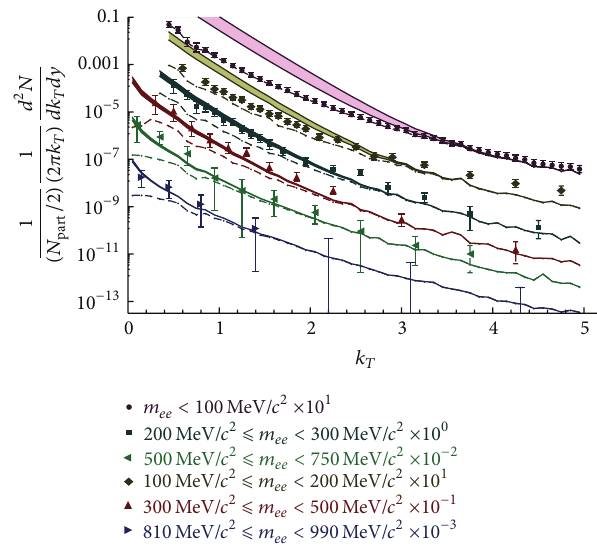
Figure 3: (Color online) The comparison between the PHENIX dilepton data and the model [2]. Min. Bias Au + Au √𝑆 200 GeV. For each color band, the 𝜂 󸀠 (or 𝛿 ) varies as 𝜂 󸀠 ≃ 4.73 ± 0.20 ( 𝛿 = 0.144 ∓ 0.045 ) at 𝜆 = 0.29